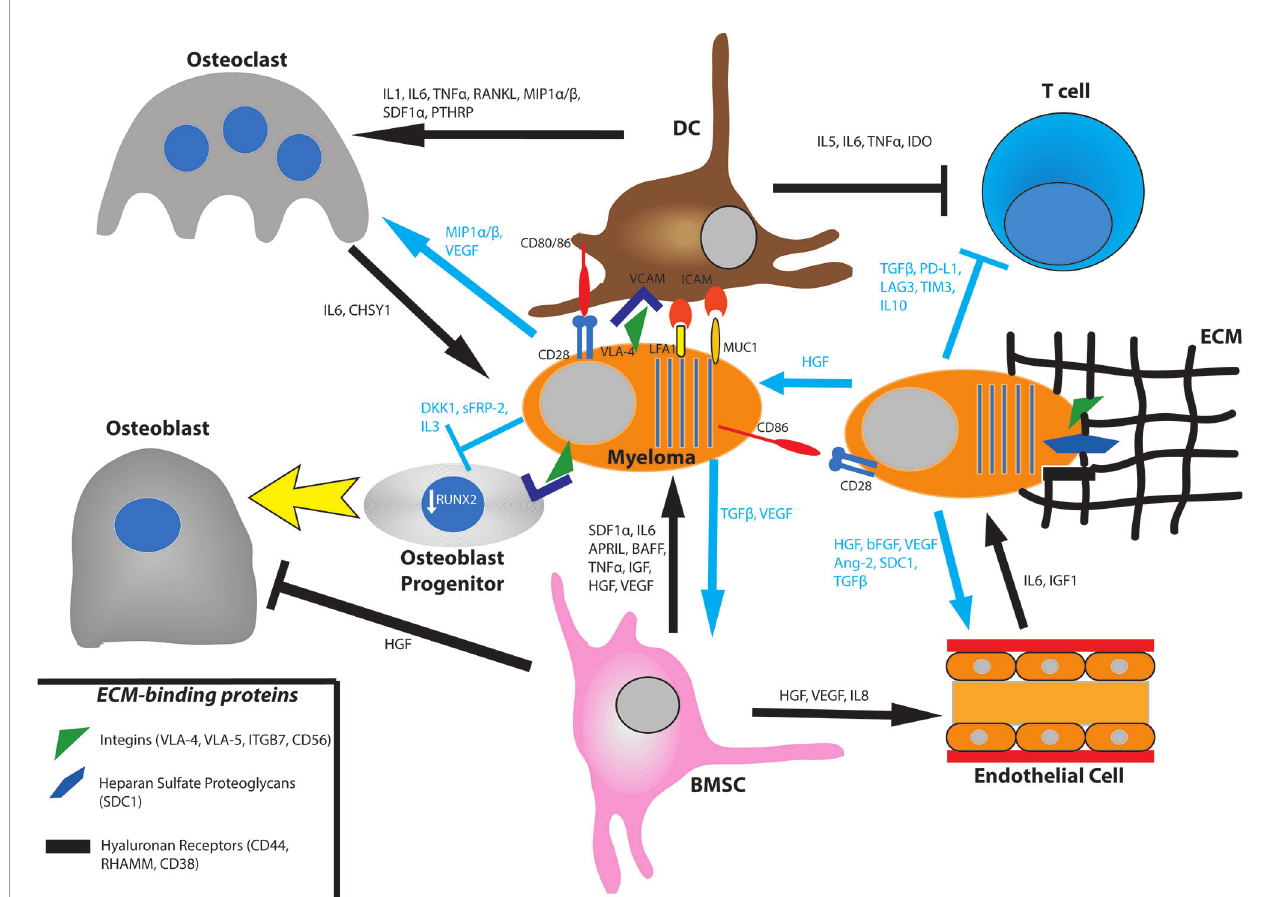
FIGURE 1 | Bone marrow interactions that promote myeloma growth and survival. Myeloma cells bind to the extracellular matrix (ECM) via integrins, proteoglycans, and hyaluronan receptors. They also directly bind to bone marrow stromal cell (BMSC) such as dendritic cells (DC) via the VCAM-VLA4, ICAM-LFA1, ICAM-MUC1, and CD80/86-CD28 axes. BMSC will produce the cytokines SDF1 a , IL6, APRIL, BAFF, TNF a , IGF, HGF, and VEGF. In turn, myeloma cells secrete TGF b and VEGF for BMSC. Myeloma cells promote osteoclast activation by secreting MIP1 a / b and VEGF and by promoting BMSC secretion of IL1, IL6, TNF a , RANKL, MIP1 a / b , SDF1, and PTHRP. They also prevent osteoblast differentiation by downregulating RUNX2 via direct binding of the VLA-VCAM axis and secretion of DKK1 and IL3. They also secrete sFRP-2 which also suppresses osteoblast differentiation. Osteoclasts produce IL6 and CHSY1 to promote myeloma cell survival. Myeloma cells induce angiogenesis in the bone marrow by secreting HGF, bFGF, VEGF, Ang-2, cleaved syndecan-1 (SDC1), and TGF b . They also promote BMSC secretion of HGF, VEGF, and IL8. Endothelial cells produce IL6 and IGF1 to in fl uence myeloma cell survival. Myeloma cells promote an immunosuppressive environment by inhibiting T cell function through production of TGF b , PD-L1, LAG3, TIM3, and IL10. They also signal to BMSC to produce IL5, IL6, TNF a , and